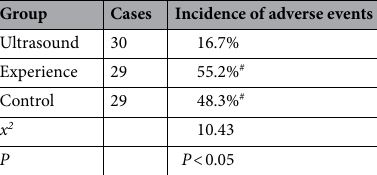
Table 5. Comparison of incidence of adverse events. # Statistical significance compared with ultrasound